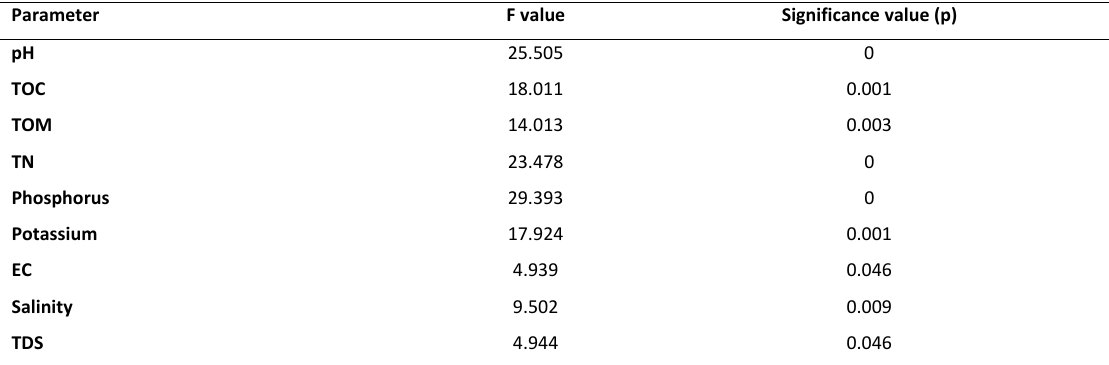
Table 4: Analysis of variance (ANOVA) for soil samples